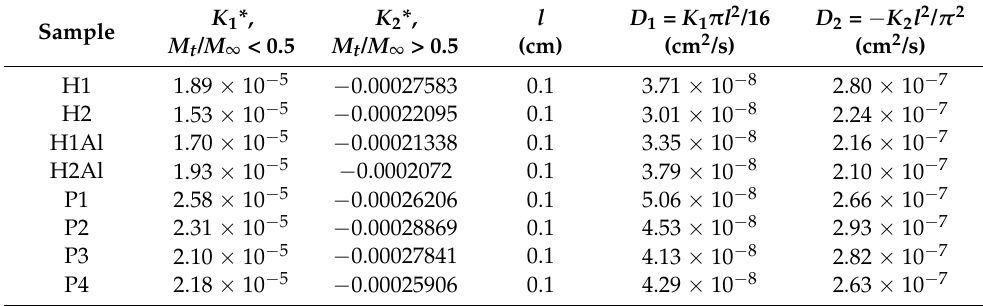
Table 5. Diffusion coefficients determined from experimental data of studied hydrogel samples.